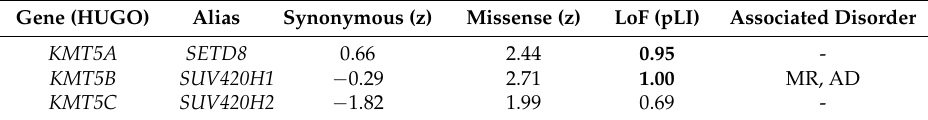
Figure 3. Schematic of the full-length KMT5B protein with its main annotated functional domain, the SET domain. Data points represent single nucleotide variants (SNVs) identified within NDD [73,77,79,80], cancer [81], or control (missense or in-frame deletions) [78] populations. Only SNVs falling within the coding sequence are depicted (i.e., intronic, splice-blocking, and synonymous mutations are excluded). While NDD and cancer variants span the full protein and cluster near the SET domain (likely disrupting gene function), there is a clear lack of mutations near the SET domain among control individuals, indicating that protein altering variants that affect the expression of the SET domain are more-likely associated with disease phenotypes. Table 1. Constraint metrics by gene and variant class for H4K20 methyltransferases.